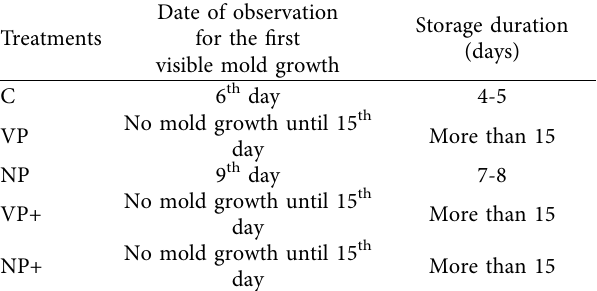
Table 1: Storage duration of injera without visible mold